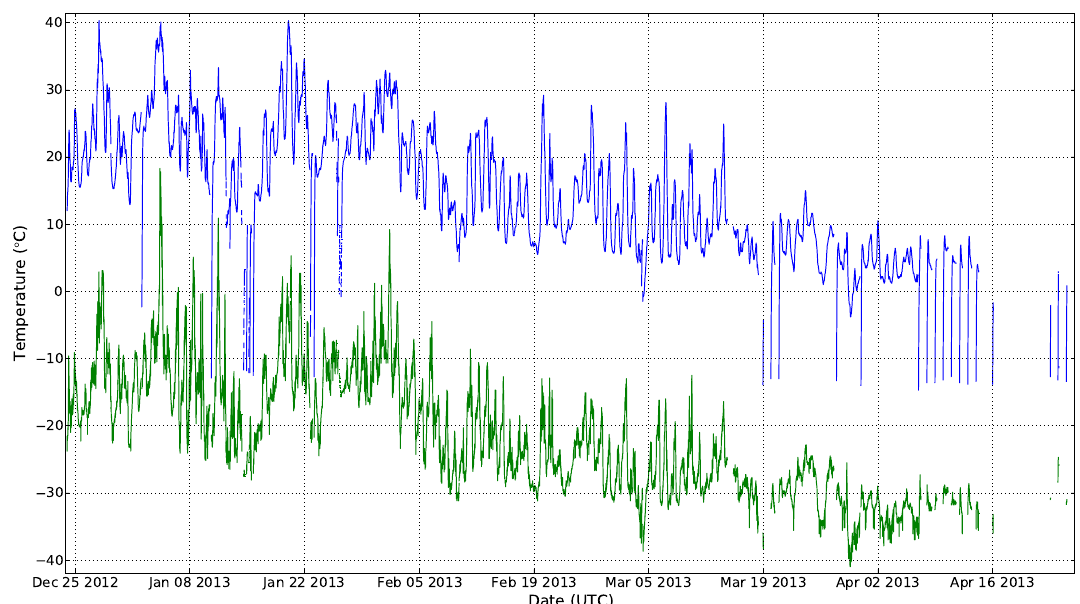
Fig. 3. Time series of temperature readings both inside (upper series) and outside (lower series) of the camera enclosure. It should be noted that the outside temperatures reported appear to be ∼ 10 ◦ C higher than the actual air